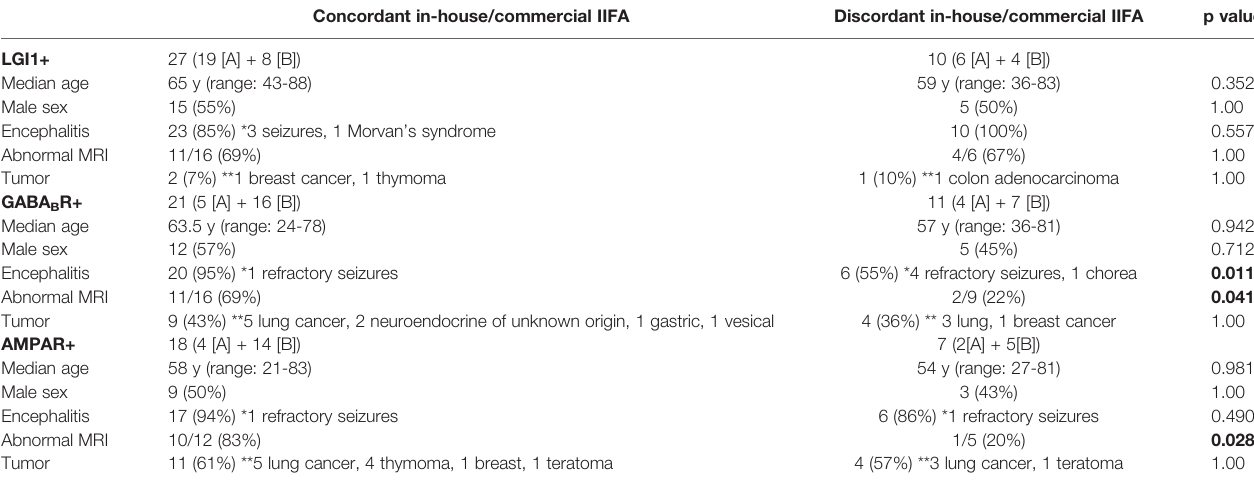
TABLE 1 | Clinical features of patients with antibodies in the cerebrospinal fl uid, and comparison between those with concordant and discordant results. Concordant in-house/commercial IIFA Discordant in-house/commercial IIFA p